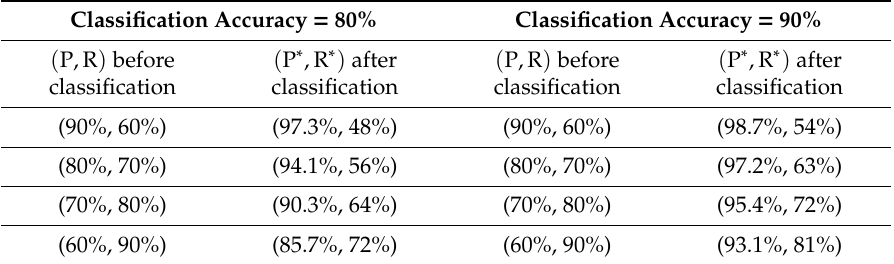
Table 3. Simulation result of detection precision and recall after classification.